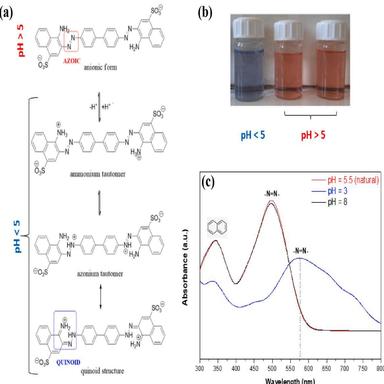
(a) Structure of CR at pH > 5 and pH < 5, (b) Image of CR solution at pH = 3, 5.5 and 8, respectively. (c) UV–Vis spectrum of CR dye at pH = 3, pH = 5.5 (natural) and pH = 8. (A colour version of this figure can be viewed online.)